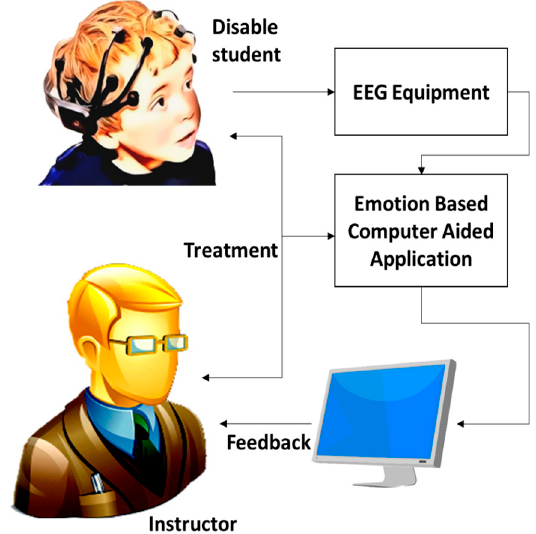
Figure 1. Computer-aided education system.